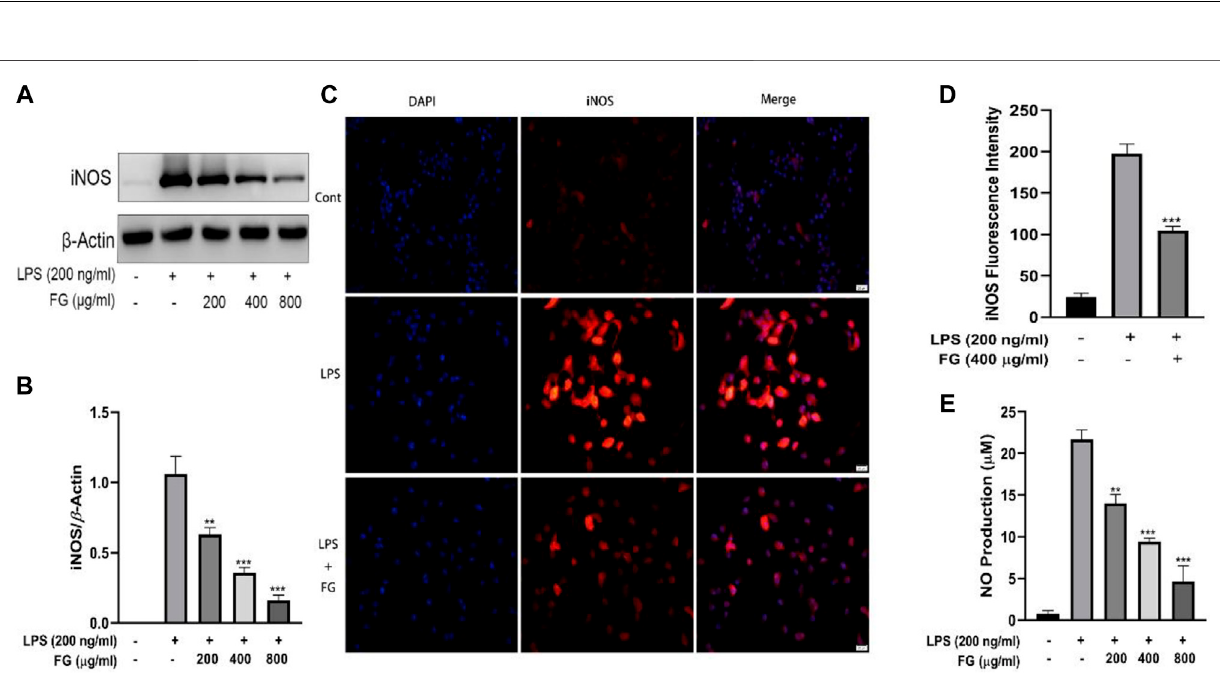
FIGURE 5 | Effects of FG on iNOS and NO generation in LPS-induced BV2 microglia. BV2 cells were treated with FG extraction (200, 400, and 800 μ g/ml) in the presenceofLPS(200 ng/ml)for24 h.ExpressionandlocalizationofiNOSwereevaluatedbyWesternblotandimmuno fl uorescence (A – D) .NOcontentinthecellculture supernatant was detected using a Griess assay kit (E) . Results are expressed as mean ± SEM of three independent experiments ( ** p < 0.01, *** p < 0.001).